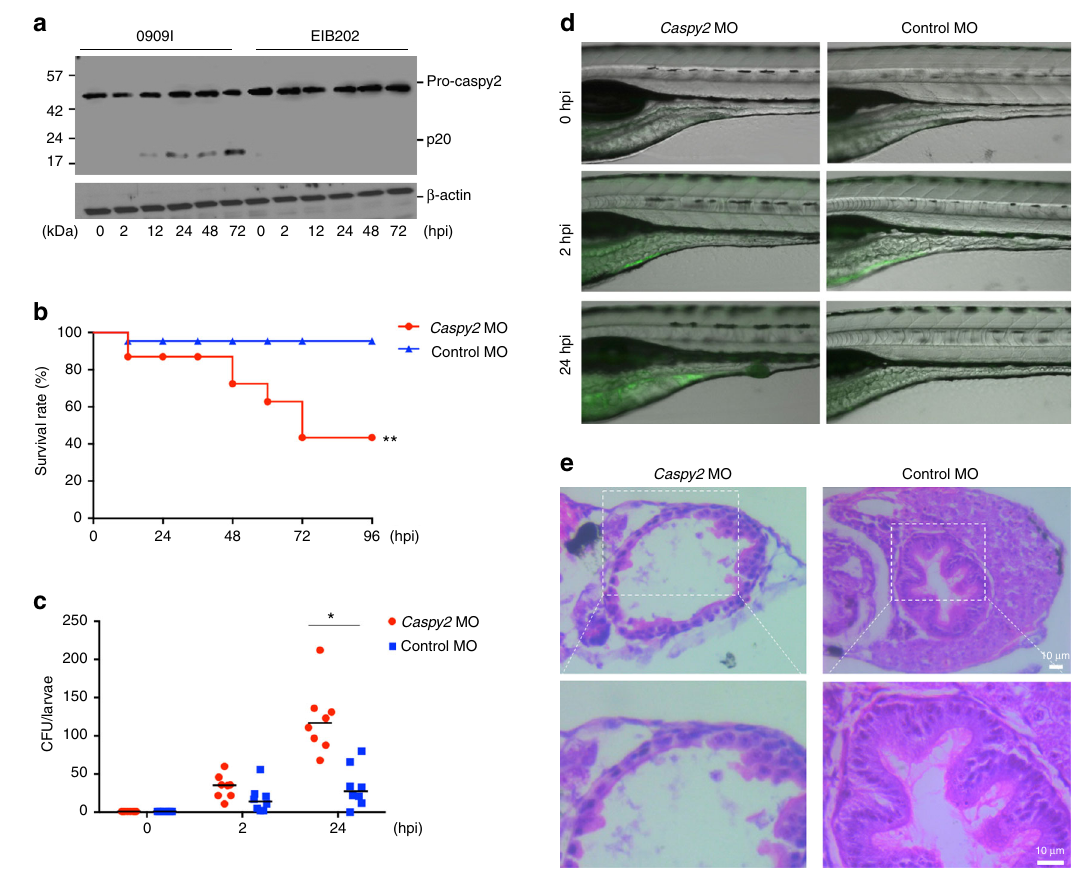
Fig. 6 Caspy2 restricts bacterial colonization of the zebra fi sh gut in vivo. a – e Control-morpholino oligonucleotide (MO) or caspy2 -MO zebra fi sh larvae at 5 days postfertilization (dpf) were infected by immersion with 10 5 colony forming units (CFU)/ml of 0909I E. piscicida . a Zebra fi sh larvae (5 dpf) were infected by immersion with wild-type (EIB202) or 0909I E. piscicida . Immunoblotting analysis of caspy2 levels at the indicated post-infection time points. b Survival of zebra fi sh larvae was monitored for 4 days. ( n = 60 for control-MO, n = 60 for caspy2 -MO). Results are representative of at least three independent experiments, ** p < 0.01 (log-rank). c Zebra fi sh larvae were collected at the indicated postinfection time points, and homogenates were made for CFU counts. Each symbol represents the average counts of fi ve larvae ( n = 100 for control-MO, n = 100 for caspy2 -MO). Results are representative of at least three independent experiments. * p < 0.05 (ANOVA). d Images of infected zebra fi sh larvae. Green fl uorescent protein (GFP)-0909I E. piscicida . e Representative images of hematoxylin and eosin (H&E) staining of gut sections from 0909I-infected control-MO or caspy2 -MO zebra fi sh larvae. Square frame, intestinal wall morphology; Scale bar, 10 µ